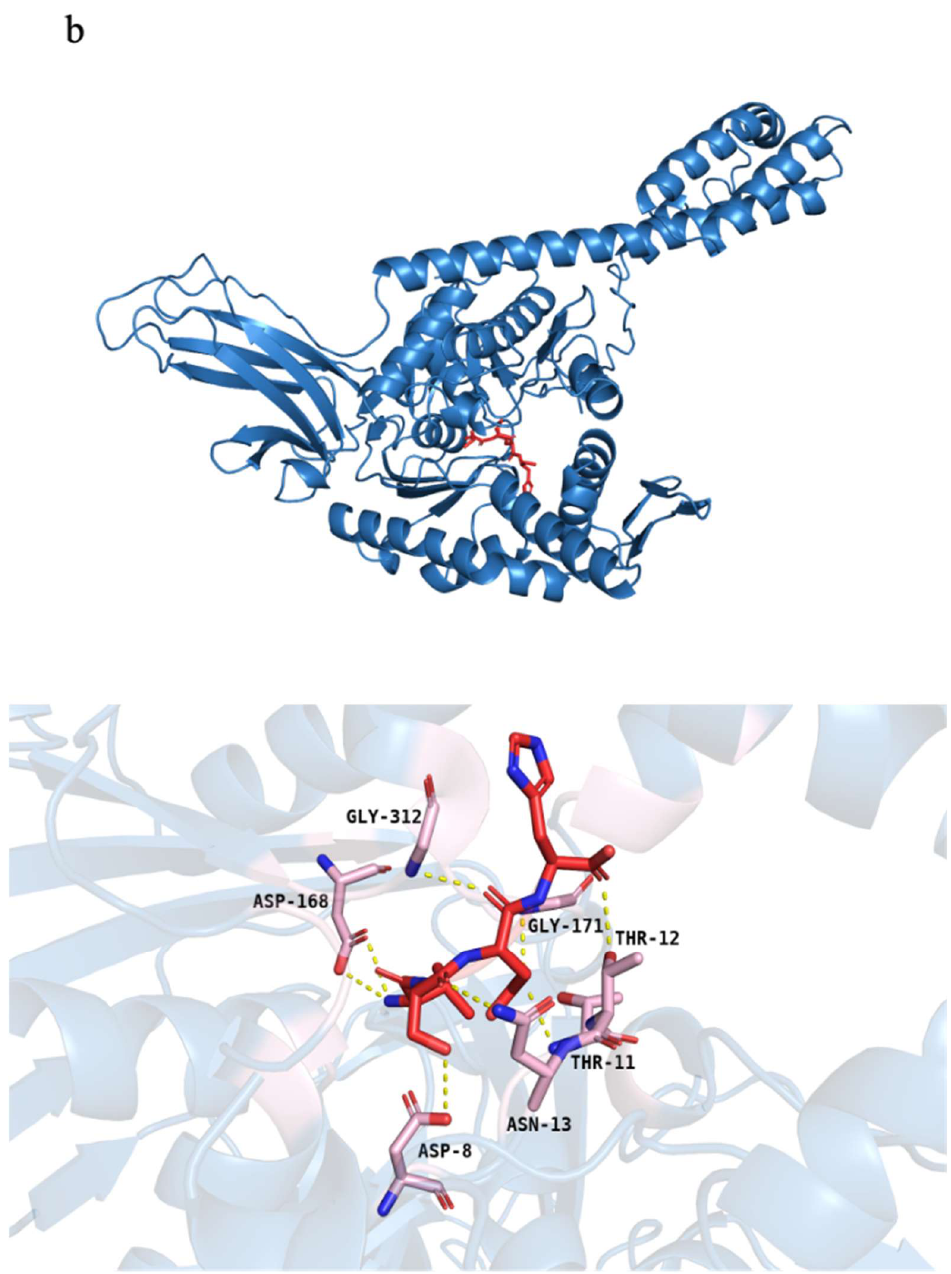
Figure 5 . Molecular docking of VSDH with enzymes related to DNA synthesis. ( a ) DNA gyrase subunit B; ( b ) DnaK . The backbone of the VSDH peptide is depicted in red lines; the active sites of both enzymes are depicted in pink lines; the yellow dots indicate hydrogen bonds .